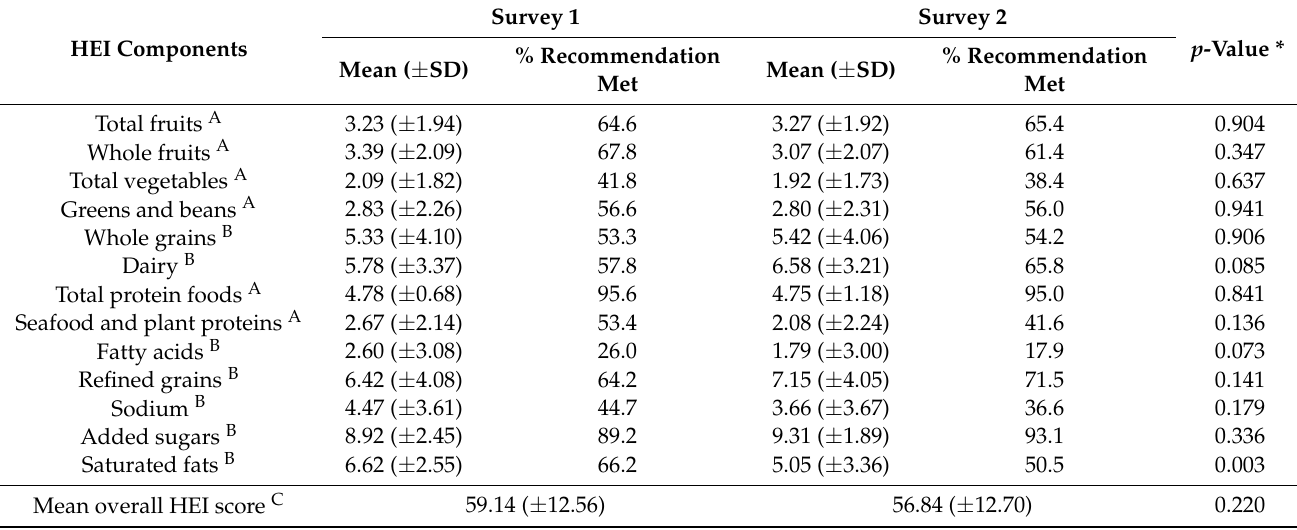
Table 2. Comparison of HEI scores of participants for survey 1 and survey